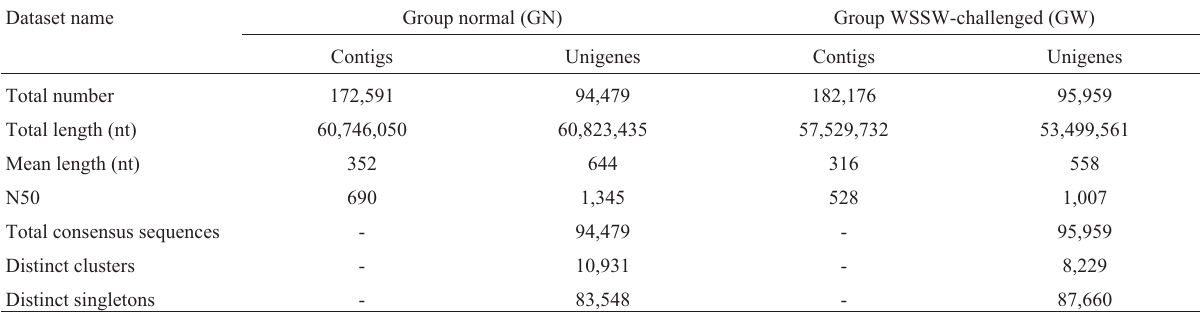
Table 2 - Summary of the assembly analysis for GN and